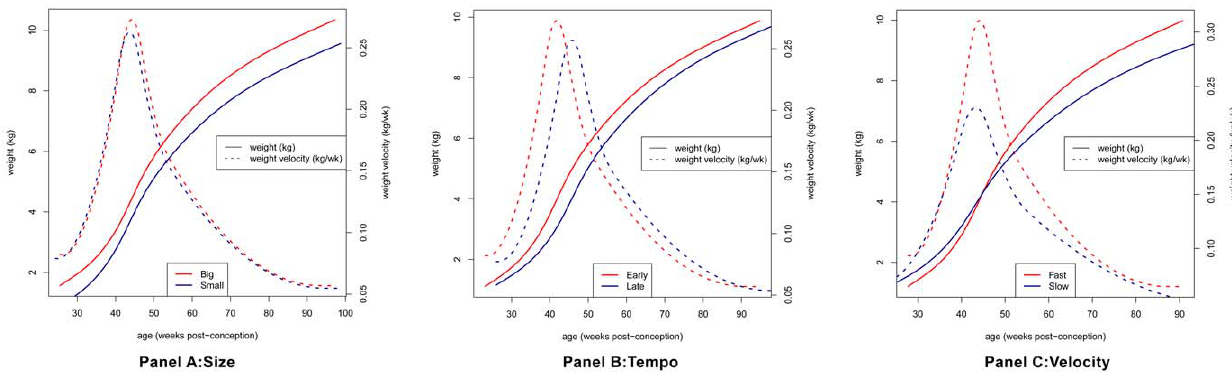
Figure 1. Average weight and weight velocity curves for extremes a of size (A), tempo (B) and velocity (C) in infancy. a Extreme groups were based on tertiles (T1, T2, T3) of SITAR parameters such that ‘small’ children were in T1 for size and T2 for tempo and velocity and ‘big’ children were in T3 for size and T2 for tempo and velocity; ‘early’ children were in T1 for tempo and T2 for size and velocity and ‘late’ children were in T3 for tempo and T2 for size and velocity; ‘slow’ children were in T1 for velocity and T2 for tempo and size and ‘fast’ children were in T3 for velocity and T2 for tempo and size.